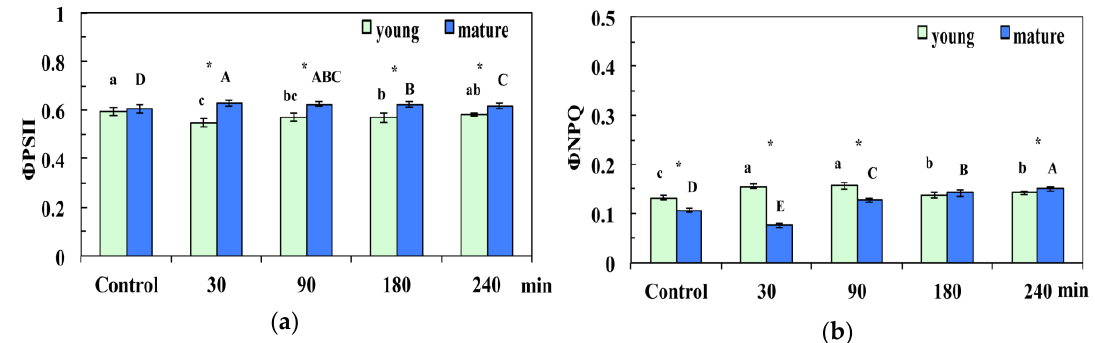
Figure 3. Changes in the quantum e ffi ciency of photosystem II (PSII) photochemistry ( Φ PSII ) ( a ), and the quantum yield of regulated non-photochemical energy loss in PSII ( Φ NPQ ) ( b ); of Arabidopsis thaliana young and mature leaves measured (at 140 µ mol photons m − 2 s − 1 ) 30 min, 90 min, 180 min, and 240 min after the foliar spay with 30 mg L − 1 of CuZn NPs or distilled water (control). Error bars on columns are standard deviations based on four to five leaves from di ff erent plants. Columns with di ff erent letters (lowercase for young leaves and capitals for mature) are statistically di ff erent ( p < 0.05). An asterisk (*) represents a significantly di ff erent mean of the same time treatment between young and mature leaves ( p < 0.05).